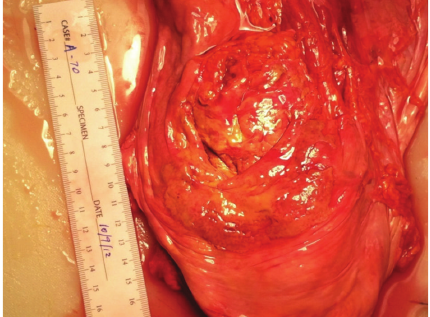
Figure 2: Anterior surfaceof thebladder domerevealing parisitoma at autopsy.